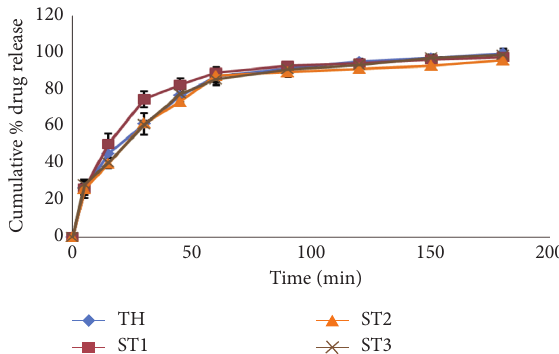
Figure 8: Plot of cumulative percentage release of alum against time for suppository formulations TH, ST1, ST2, and ST3. (ST: shea butter+theobroma oil; TH: theobroma oil). Error bars represent the standard deviation of six